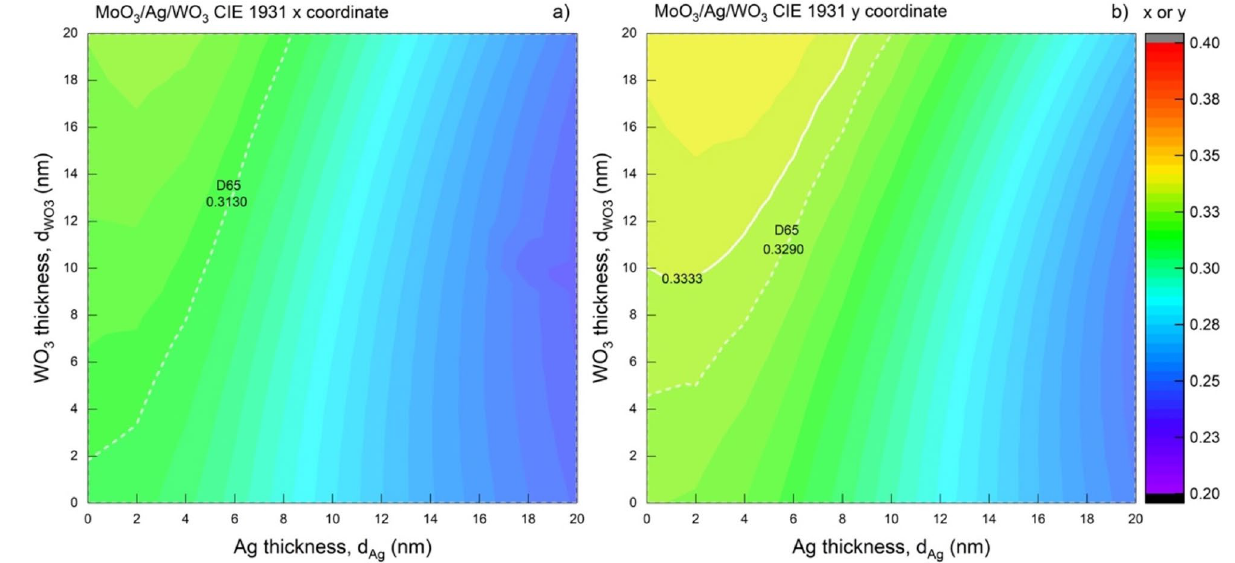
Figure 8. Mapping of the CIE 1931 colour coordinates of the transparent contact structure depending on the thickness. The distribution of ( a ) CIE x and, ( b ) y colour coordinates corresponding to the d Ag and d WO 3 values for MoO 3 /Ag/WO 3 (10/ d Ag / d WO 3 nm). The dashed and solid white lines belong to the contours representing the colour coordinate of the D65 and achromatic point,